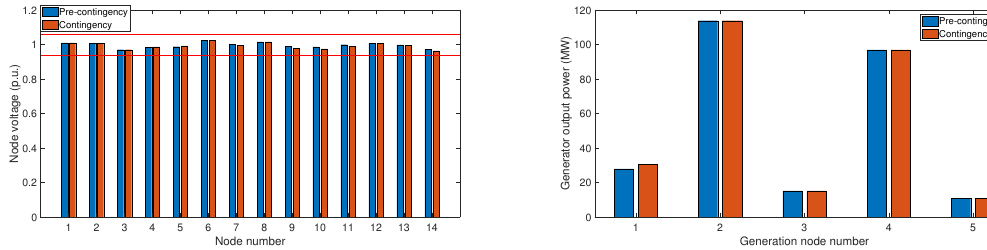
Figure 9. Voltage and power dispatched implementing the QCQP results in a power flow of the network prior to and after contingency of branch 10 (generation nodes are, respectively, nodes 1, 2, 3, 6, and 8).